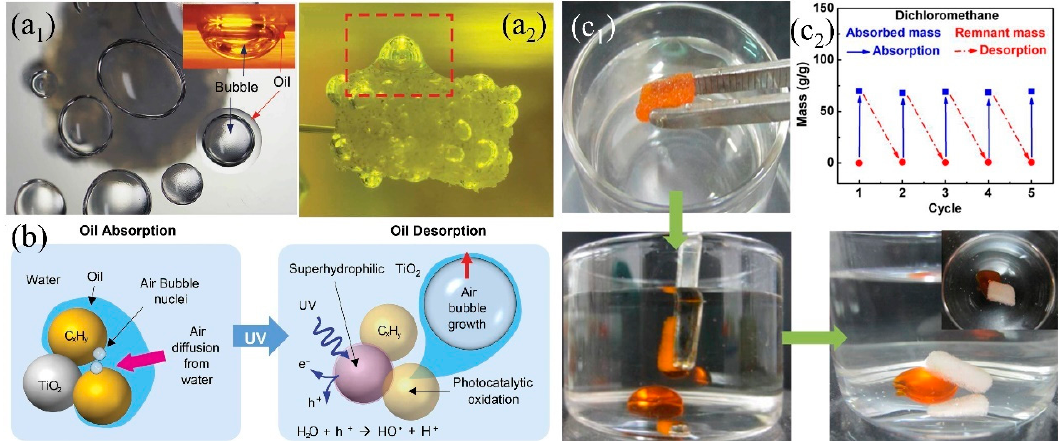
Figure 16. ( a ) Photograph of ( a 1 ) top view of desorbed oil/bubbles (the inset shows the side view), ( a 2 ) oil/bubble desorption (about 24 h), ( b ) schematic diagram of oil desorption under UV light response [117]; reproduced with permission from Nature. ( c 1 ) Photograph of rapid desorption of oil by slightly squeezing the sponge at 20 °C, ( c 2 ) cycling performance of OTS/PNIPAAm sponge adsorption/desorption at different temperatures [205], reproduced with permission from American Chemical Society.